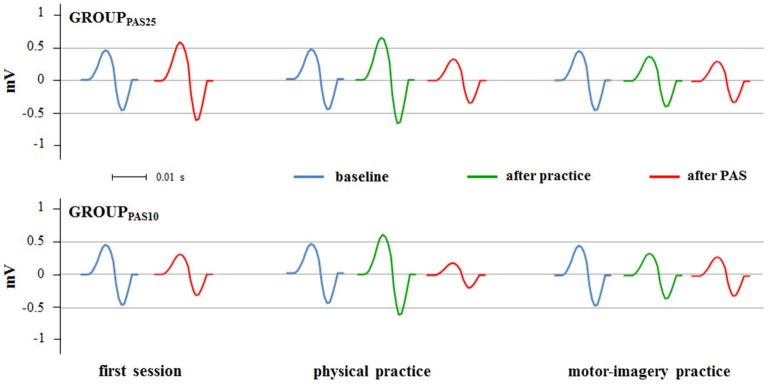
PAS effects on MEPs amplitude in different experimental sessions (first session, physical practice and motor-imagery practice). Raw MEPs obtained from two single representative subjects belonging the GROUPPAS25 and GROUPPAS10 are shown.